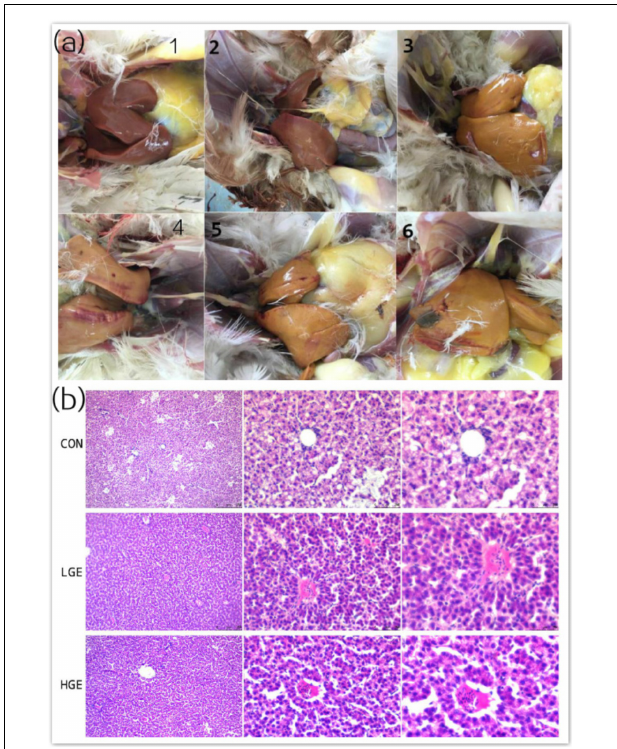
FIGURE 2 | (a) Clinical scores for chicken livers were divided into six levels representing different degrees of FLS. (b) Chicken livers were stained with HE, viewed under a microscope (100 × , 400 × , and 600 × ), and assigned pathological scores representing the degree of FLS. The categorization scheme is shown in Table 5 .